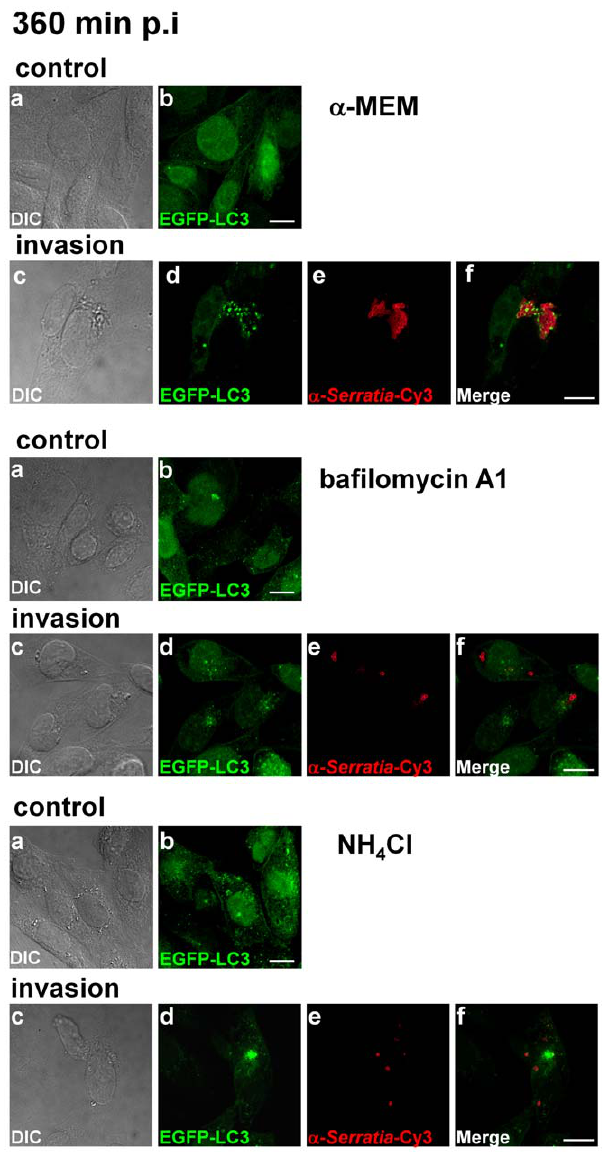
Figure 7. Confocal microscopy analysis of the effect of altering vacuolar acidification on Serratia invasion. CHO-EGFP-LC3 cells subjected to the invasion assays as described in Fig. 5A were visualized by confocal laser microscopy. a and b panels show representative images of control, non-invaded cells and c-f panels depict invaded cells incubated with a -MEM, a -MEM + 100 nM Baf or a -MEM + 10 mM NH 4 Cl, as indicated. Bacteria were detected with antibodies anti- Serratia coupled with a secondary antibody labeled with Cy3. Representative DIC (c), EGFP-LC3 green fluorescence (d), red fluorescence-labeled bacteria (e) and merged images (f) are shown. At least 300 cells were inspected for each condition in two independent experiments. Bars: 10 m